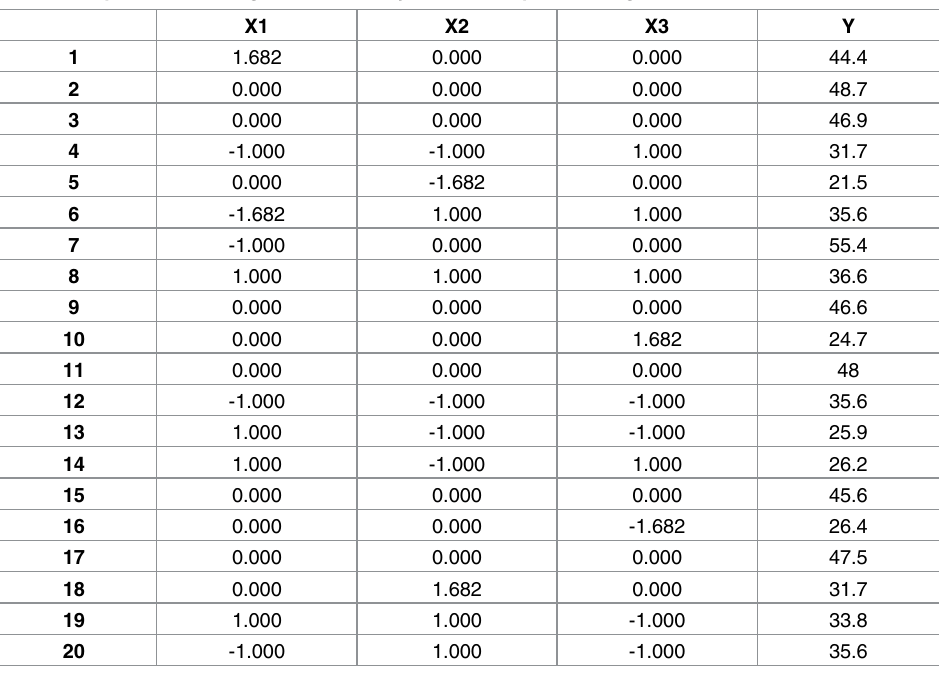
Table 3. Experimental design and results by central composite